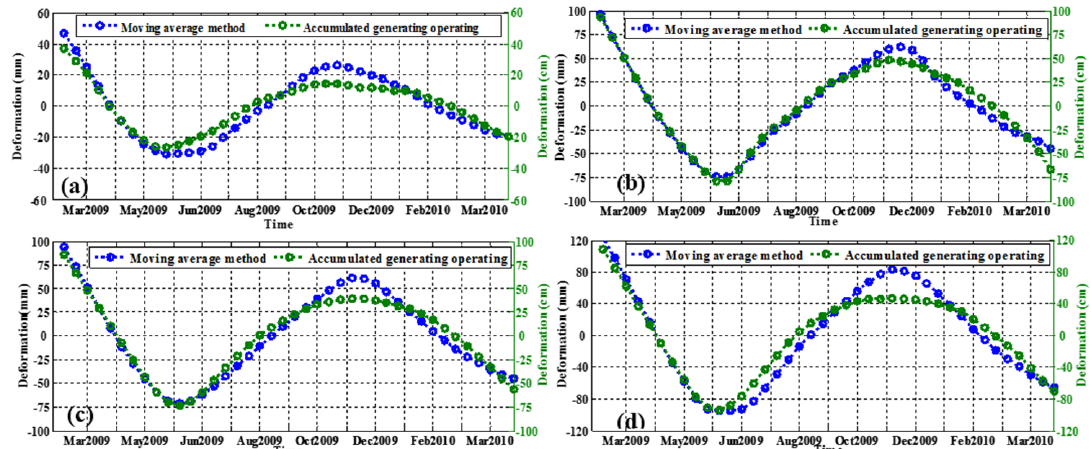
Figure 12. A comparison of the calculated seasonal deformations between the moving average method and the accumulated generating operation method. Deformation time series in both range and azimuth were plot in ( a , b ) for CR2 and ( c , d ) for R14.